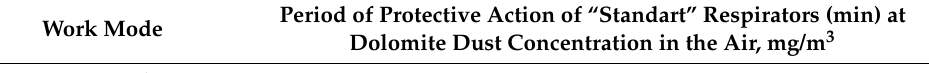
Table 4. Period of protective action of “Standart” respirators at various dolomite dust concentrations in the